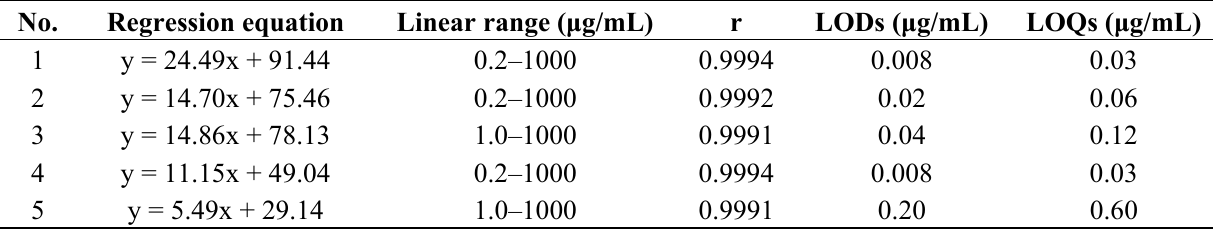
Table 1. Calibration parameters of UPLC-MS analysis for the 5 compounds. ( 1 :